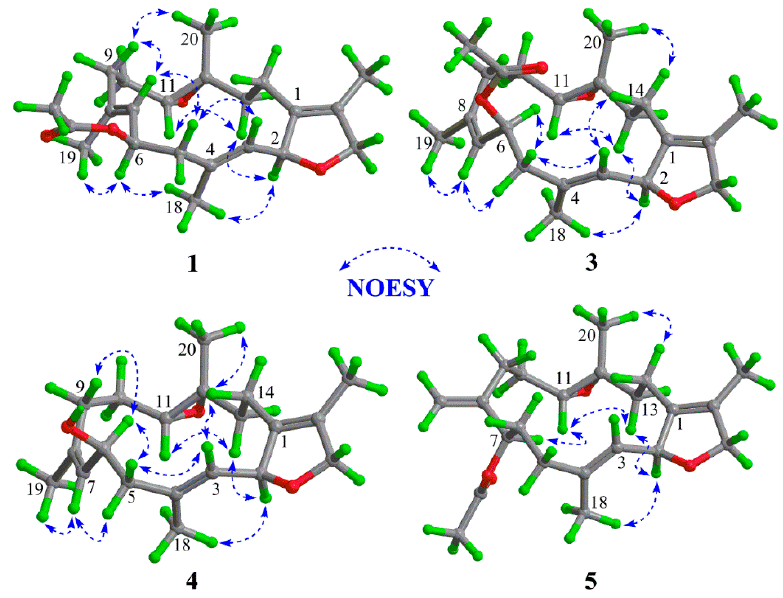
Figure 3. Key NOESY correlations of compounds 1 and 3 – 5 .